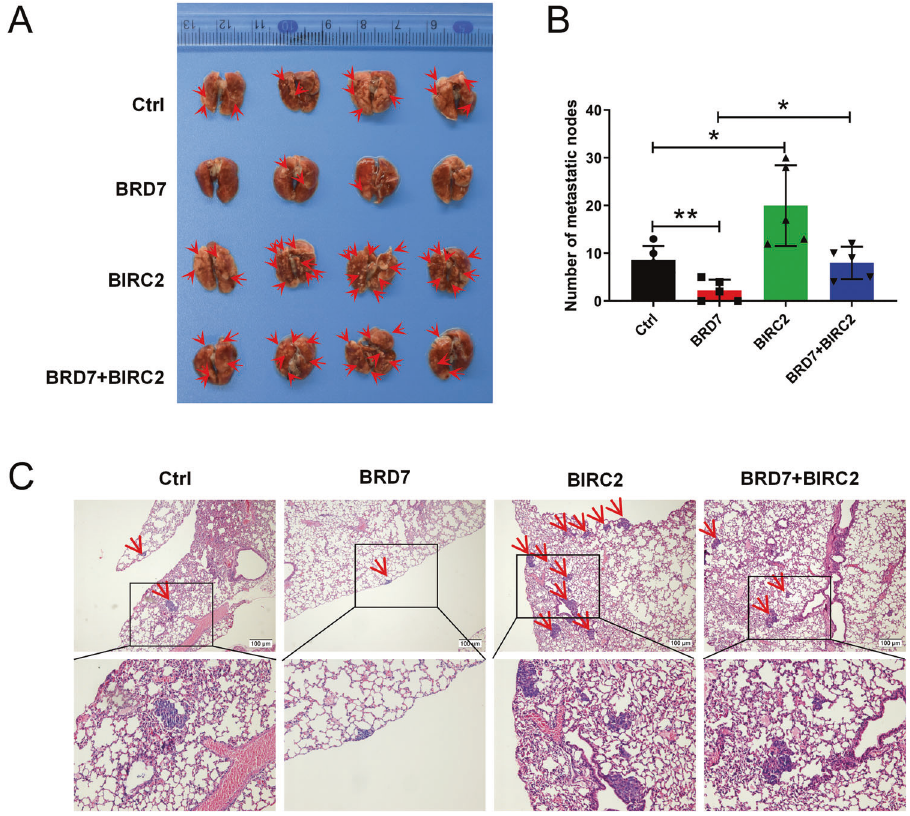
Fig. 7 BRD7 inhibits tumor metastasis in vivo through regulation of BIRC2 expression. A Representative image of macroscopic mouse lung tissue in the metastatic tumor model. B The number of metastatic lung nodules of every mouse per group was counted in microscopy. C H&E staining is shown in control, BRD7 overexpression, BIRC2 overexpression and BIRC2 restoration group. Red arrows indicate metastatic tumors, scale bar, 100 μ m. Error bars represent the mean ± SD. **P < 0.01, ***P <